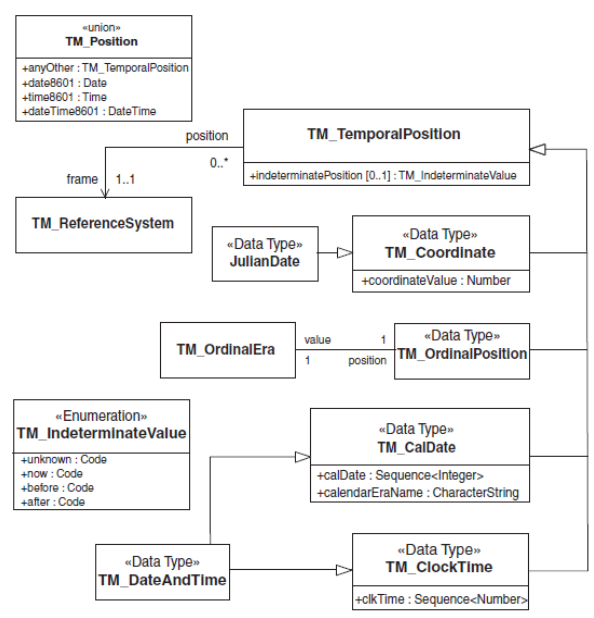
Figure 5 Conceptual schema of temporal position (ISO,